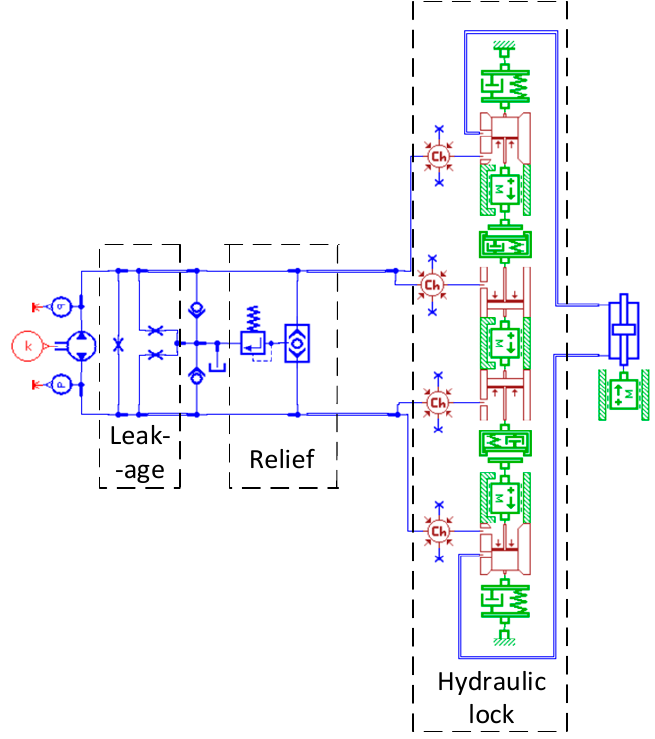
Figure 6. AMESIM model of the hydraulic system.